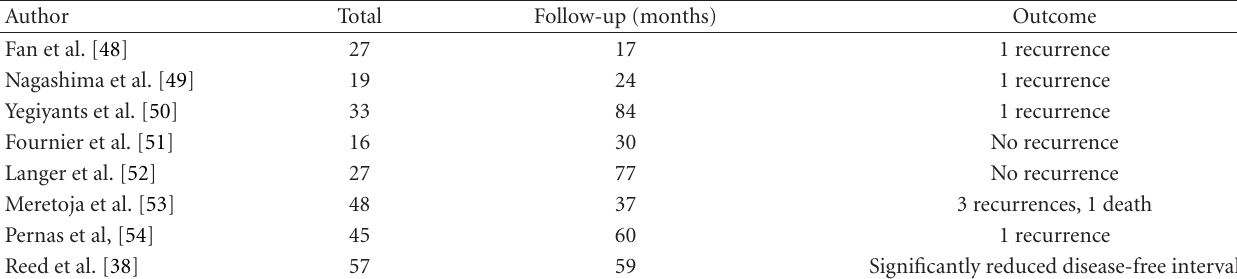
Table 3: Studies of patients with micrometastases not treated by completion mastectomy.